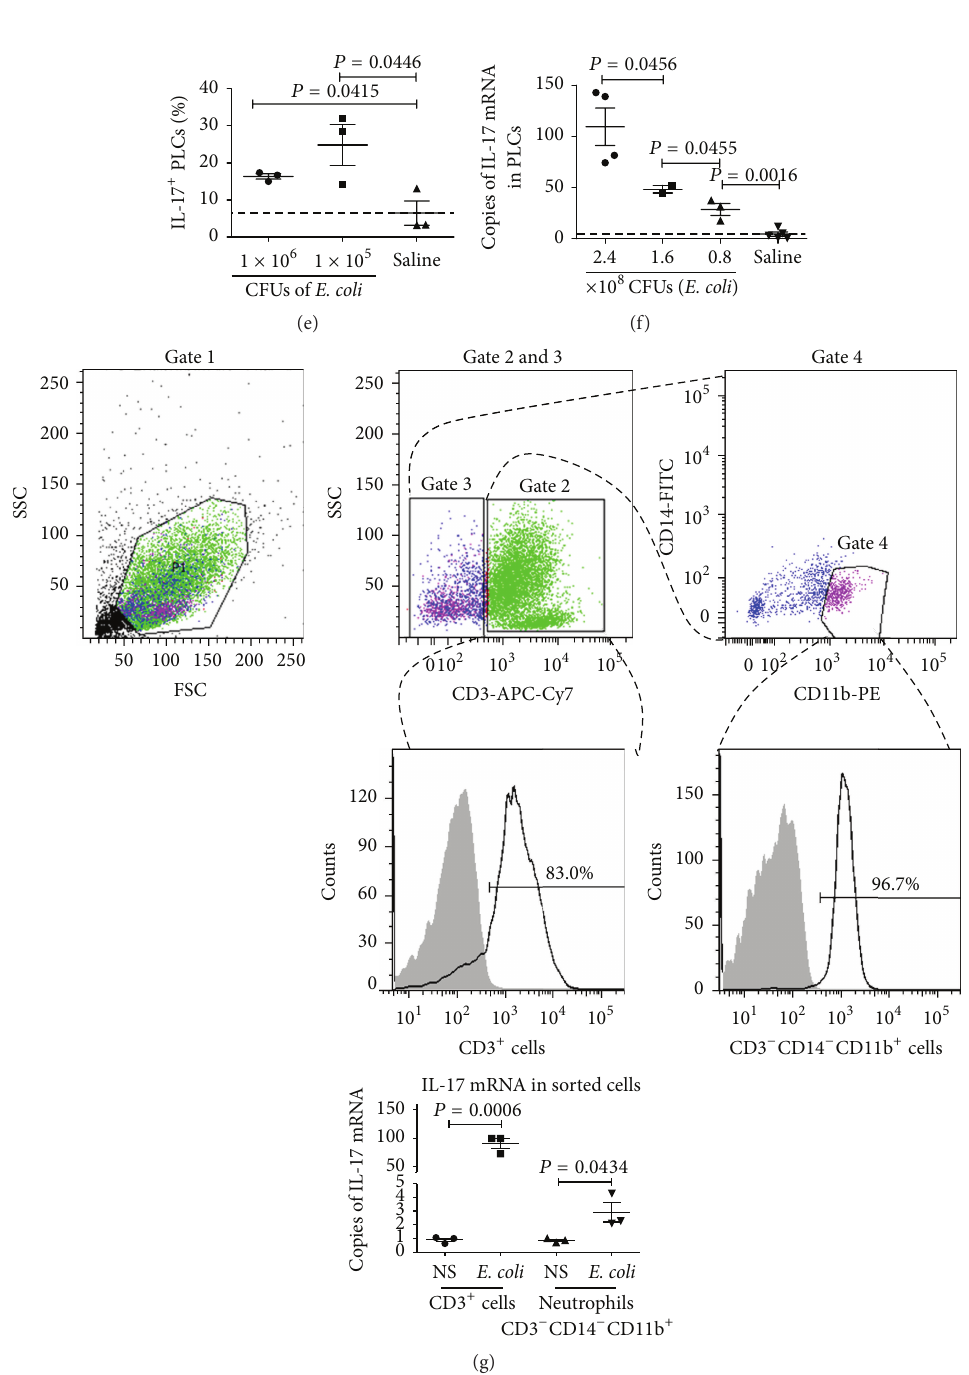
Figure 5: The ratios of IL-17 + PMNs and macrophages in PLCs from mice infected with E. coli intraperitoneally. ICR mice were infected with E. coli at 3 doses or received saline and sacrificed at 18, 48, and 72 hours to harvest their PLCs. The PLCs were stained with fluorescence-labeled mAb of anti-CD45, anti-CD11b, and anti-IL-17, followed by detection with flow cytometry or lysed to isolate total RNA for amplifying IL-17 mRNA by qPCR. (a) PMNs gated from the CD45 + PLCs (gate 1) and CD11b + PMNs or CD11b − PMNs from the gated PMNs (gate 2). (b) Ratios of IL-17 + PMNs in CD11b + PMNs. (c) Ratios of IL-17 + PMNs in CD11b − PMNs. (d) Ratios of IL-17 + macrophages. (e) Percentages of IL17 + PLCs in the PLCs cocultured with E. coli . (f) Copies of IL-17 mRNA in the PLCs. Each point represents the data from one mouse. (g) IL-17 mRNA expression in sorted CD3 + cells or CD3 − CD14 − CD11b +